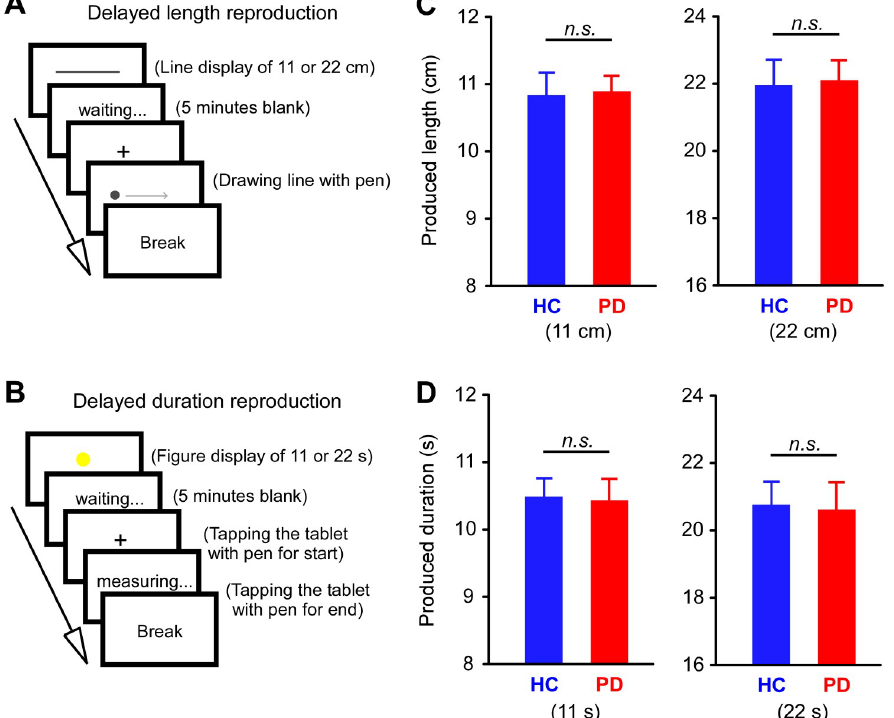
Fig 1. Delayed reproduction task. ( A ) Line length was estimated by drawing a line with a pen to reproduce line length (11 or 22 cm) after 5 minutes. The sample line was presented for 11 s. ( B ) Time duration was estimated by tapping a tablet with a pen to reproduce a sample presentation (11 or 22 s) after 5 minutes. ( C ) The estimated lengths did not differ between healthy controls (HC) and patients with Parkinson’s disease (PD) in the tasks involving both the 11 cm and 22 cm lines. ( D ) The estimated durations did not differ between the HC and PD groups in the tasks involving both 11 s and 22 s